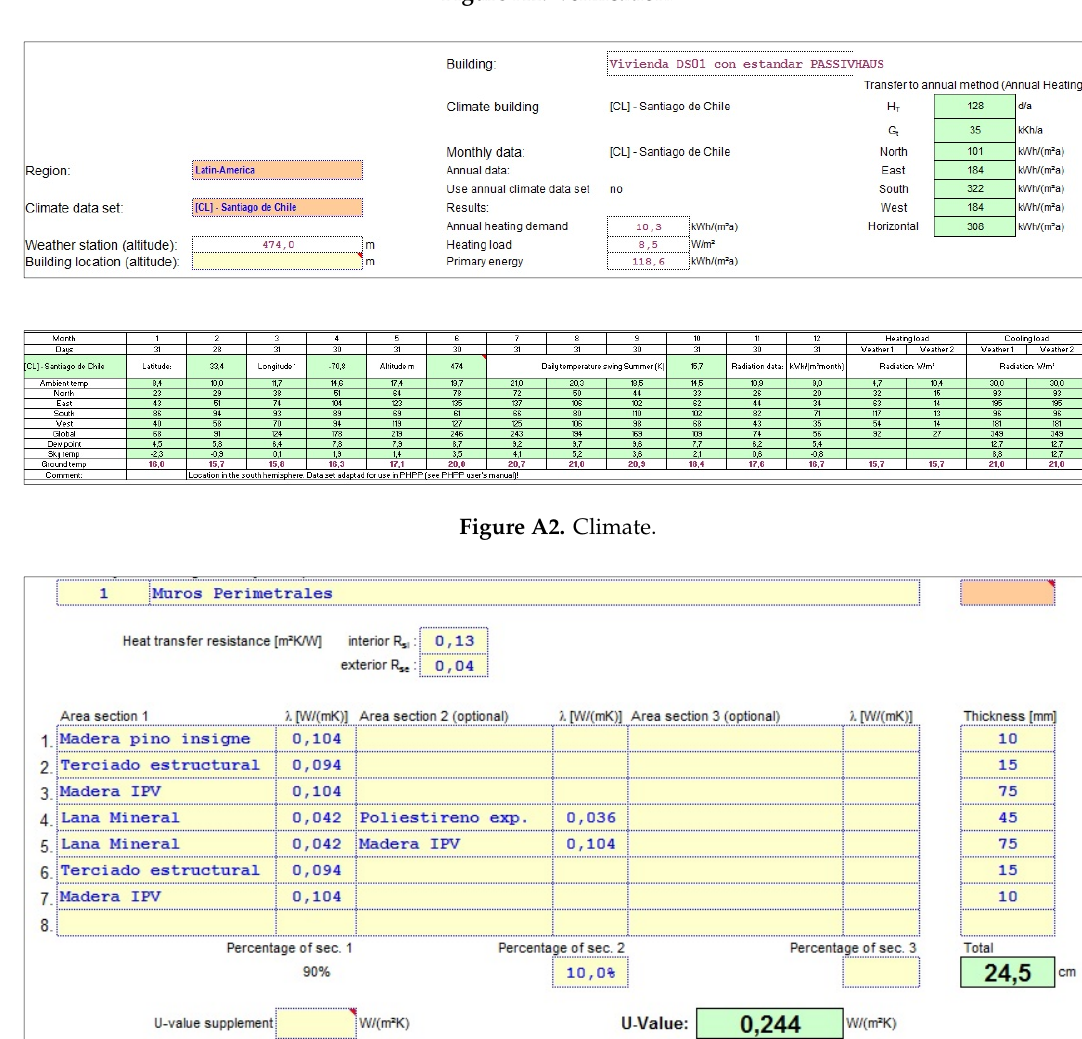
Figure A1. Verification.